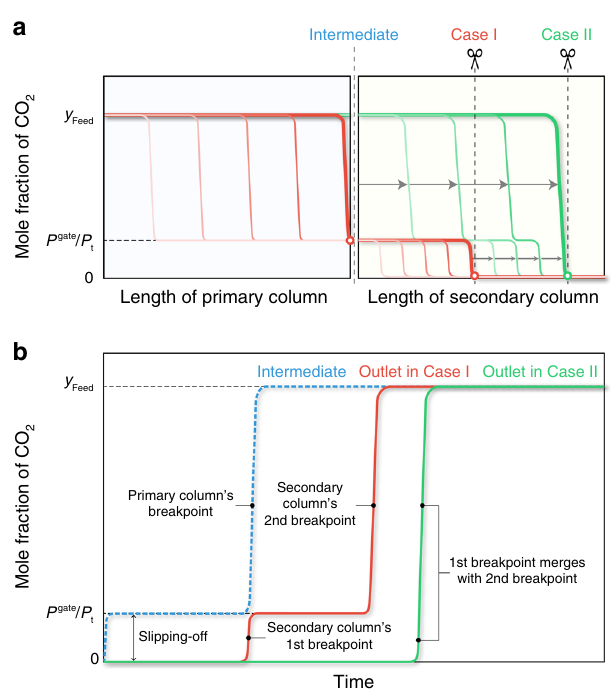
Fig. 7 Development of CO 2 fraction in gas stream passing through the sequential-column system. a Movement of the mass-transfer zone in the primary and secondary columns containing a fl exible MOF and a Langmuir- type adsorbent, respectively, where red and green lines show the CO 2 fraction in the stream in the columns before and after the primary column breaks through, respectively. b Breakthrough curves at the three positions indicated by dashed lines in a , where “ intermediate ” is the outlet of the primary column, “ case I “ is the front of the mass-transfer zone in the secondary column when the primary column breaks through, and “ case II ” is the front of the mass-transfer zone when the fi rst breakpoint just merges with the second